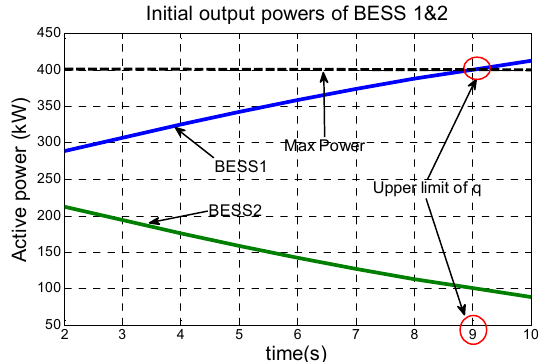
Figure 6. The relationship between the coefficient q and the output powers of BESSs.